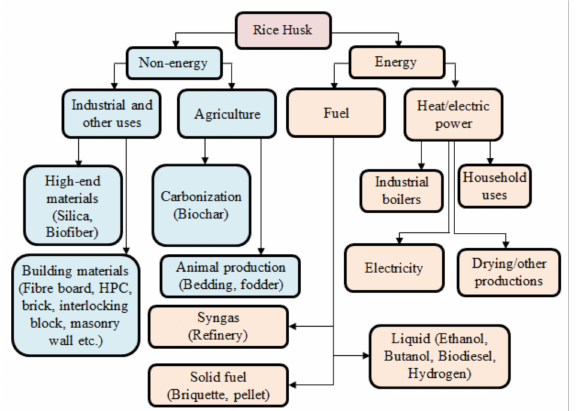
Figure 14. The potential applications of RHA